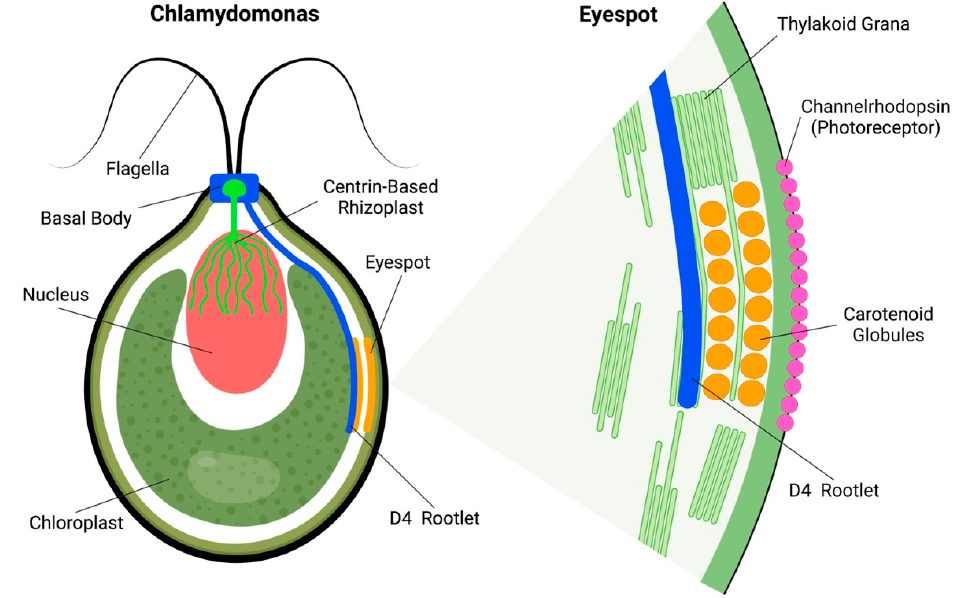
Figure 1. Algal Eyespot of Chlamydomonas. Chlamydomonas alga with two flagella associated with the basal bodies which intracellularly organize intracellular bundles of microtubules (known as rootlets) of which the D4 bundle anchors the eyespot. This eyespot is constructed from chloroplast thylakoid membranes and carotenoid globules, aligned under the plasma membrane which is enriched with photoreceptor channelrhodopsin. Besides the bundles of microtubules, the basal body also organizes the centrin-based contractile nucleo-basal body connector anchoring the nucleus. M4, M2 and D2 rootlets are not shown in this simplified scheme.